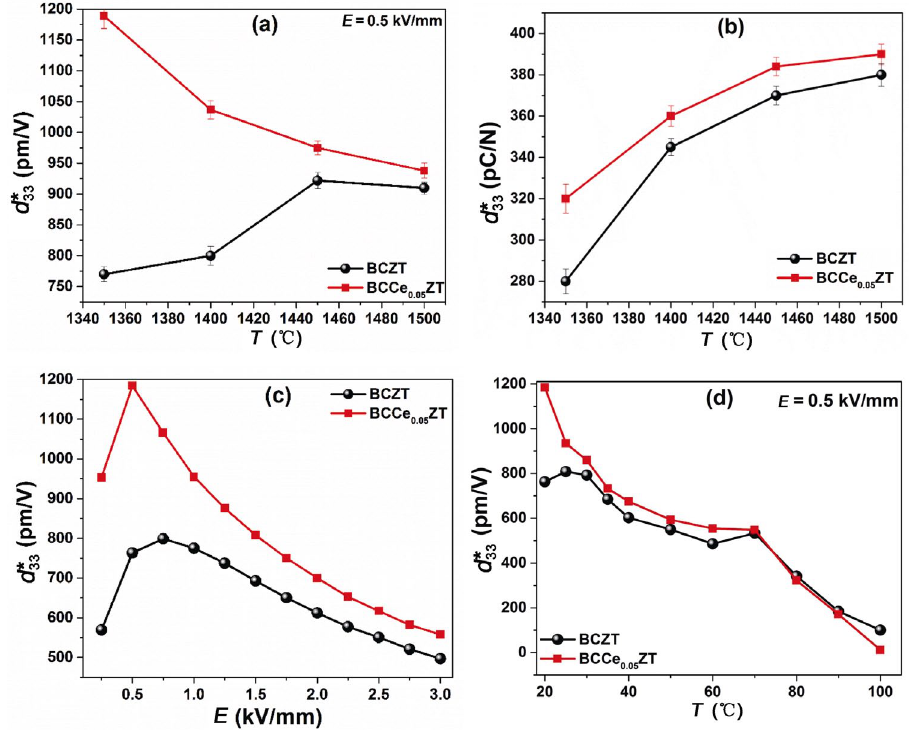
Fig. 7 Variations in piezoelectric coefficients with sintering temperature: (a) large signal d * 33 , (b) small signal d * 33 , (c) electric field dependence, and (d) temperature dependence of the large signal d * 33 for BCZT and BCCe 0.05 ZT